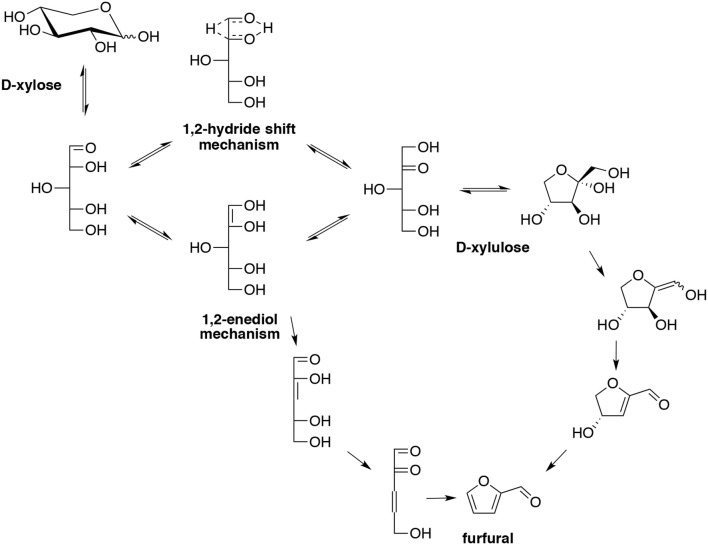
Plausible mechanism of D-xylose reaction to furfural in acidic media (Danon et al., 2014).